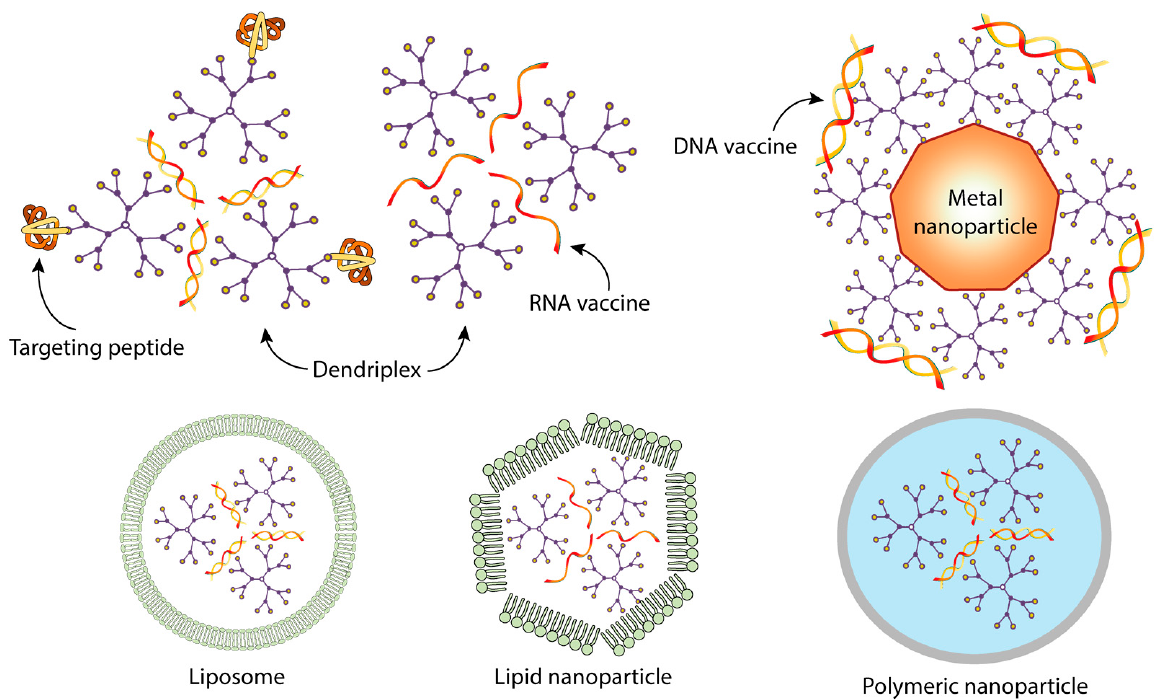
Figure 11. Typical structures of dendrimer-based complexes used for the delivery of DNA and RNA vaccines.